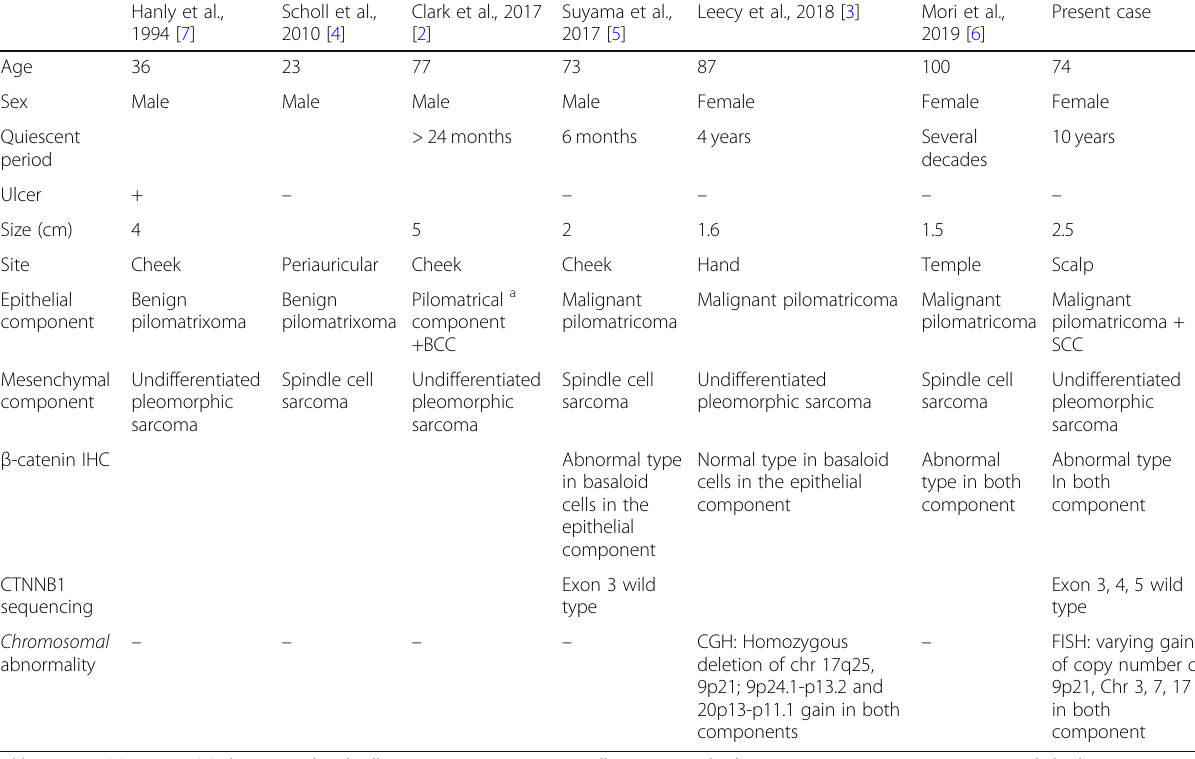
Table 3 Summary information of 7 cases of pilomatrical